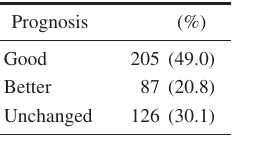
Table 3. Prognosis of taste disorders according to patient